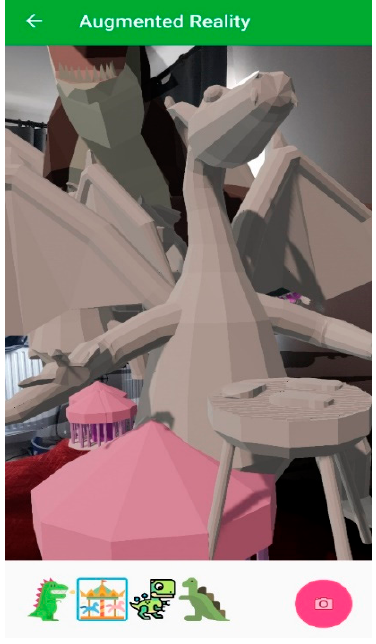
Figure 13. Augmented reality module.